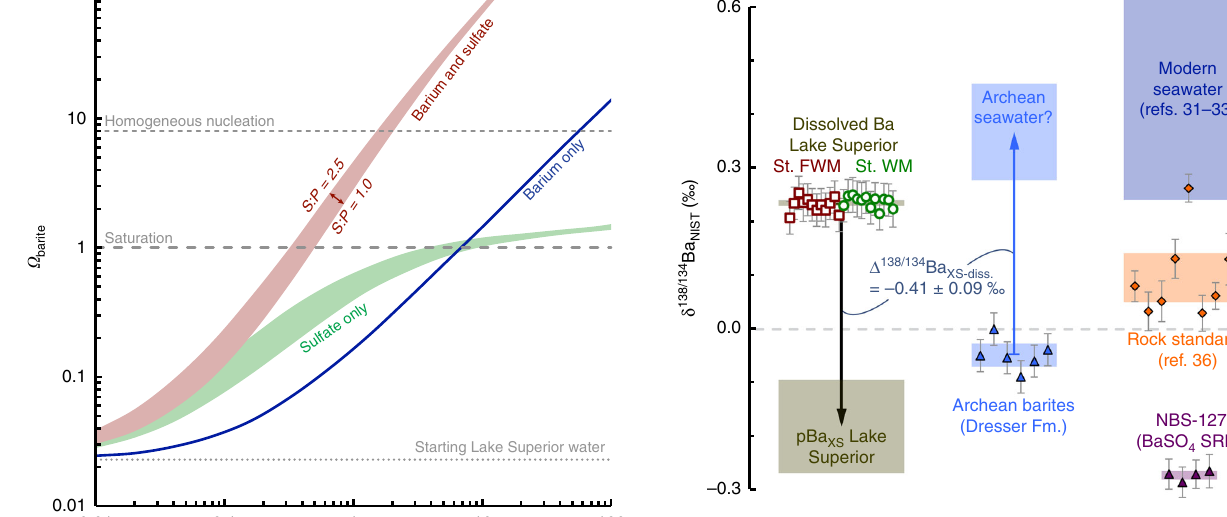
Fig. 6 Isotopic offsets for barites precipitated under low ambient sulfate imply Archean seawater possessed heavy Ba-isotopic compositions. Using Δ 138/134 Ba = − 0.41 ± 0.09 ‰ (this study), Archean barites from the XS − diss. Dresser Formation imply a dissolved Ba source with δ 138/134 Ba NIST = +0.37 ± 0.09 ‰ , similar to the range reported for modern seawater 31 – 33 , and considerably offset with respect to igneous rock standards (data are for AGV-1, G-2, BHVO-1, QLO-1, BIR-1, JG-1a, JB-1a, JR-1, and JA-1 36 ). Values for NBS-127, a barite standard reference material commonly used for S- and O-isotopic normalization, were determined as δ 138/134 Ba NIST = − 0.27 ± 0.02 ‰ ( ± 2 SD, n = 4), which we report here as a reference value for future studies. Shading indicates mean ± 2 SE for each sample